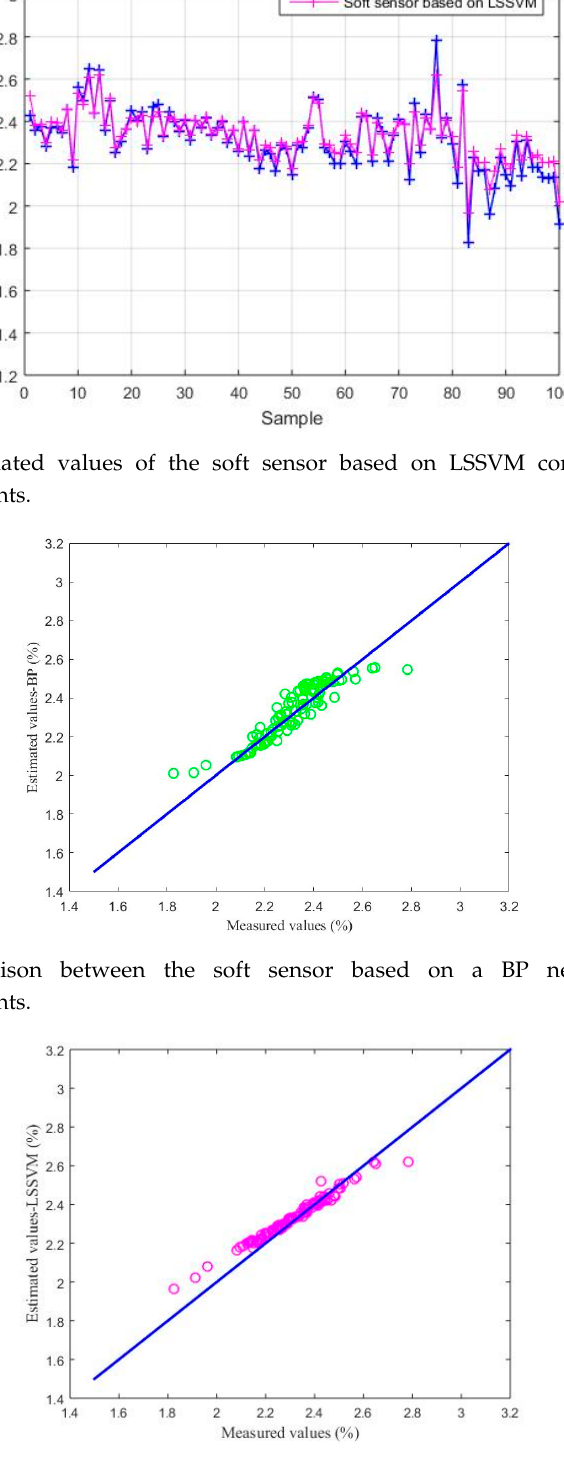
Figure 9. Comparison between the soft sensor based on LSSVM and laboratory measurements.